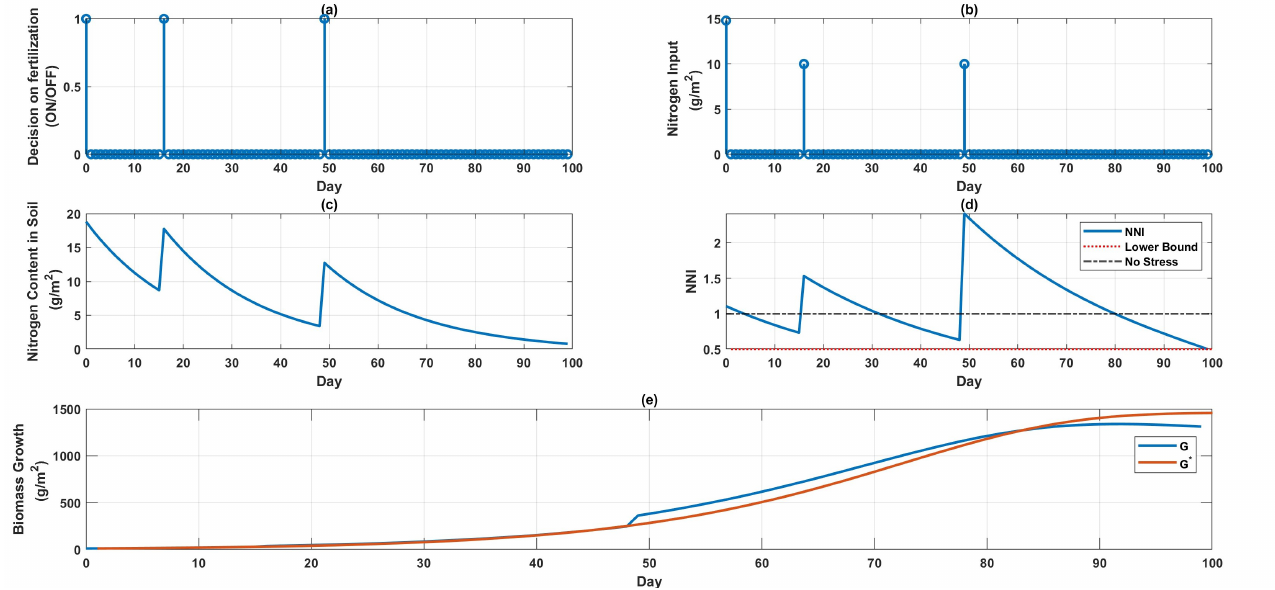
Figure 1. Maximizing the growth. ( a ) Indicates the days when fertilizer delivery is ON, ( b ) displays how much fertilizer is required on these days, ( c ) represents the nitrogen concentration of the soil, ( d ) the NNI level, and ( e ) the progressive development of biomass. Table 1. Case 1 result: Maximizing the